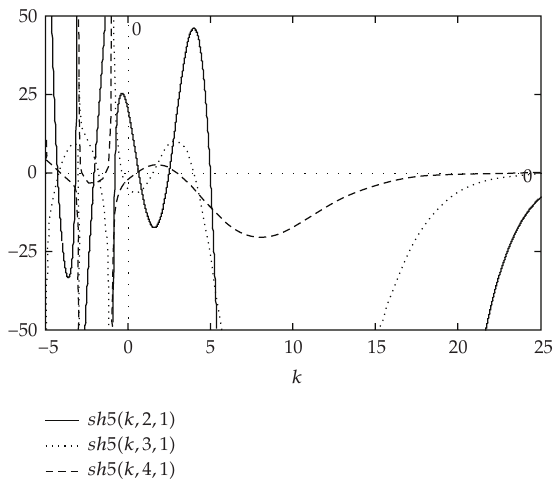
Figure 7: The graphics of the fifth derivative of the hyperspherical functions with respect to the argument n .